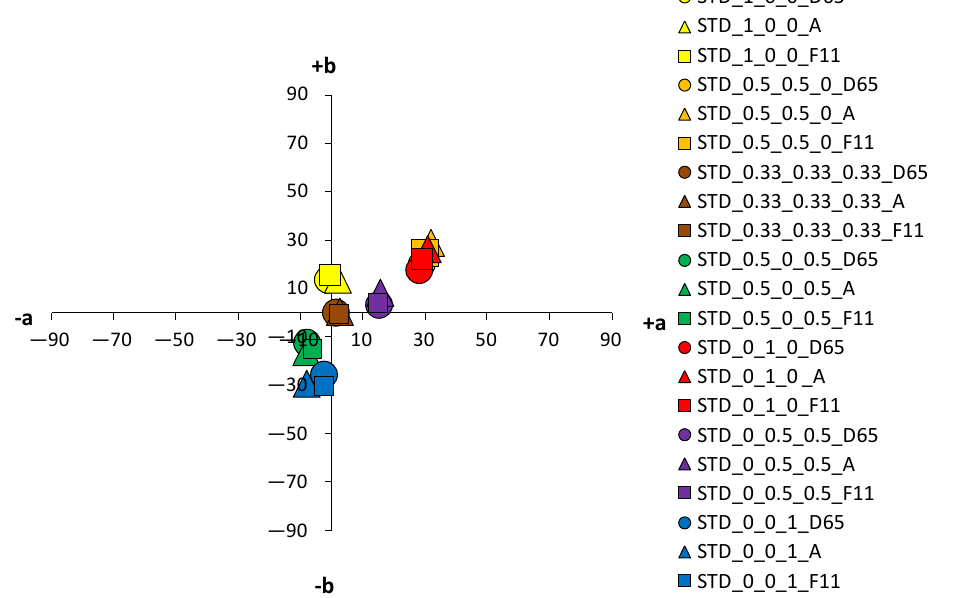
Figure 7. Color coordinates of standard cotton fabric dyed with 1% owf dyes under different light sources.